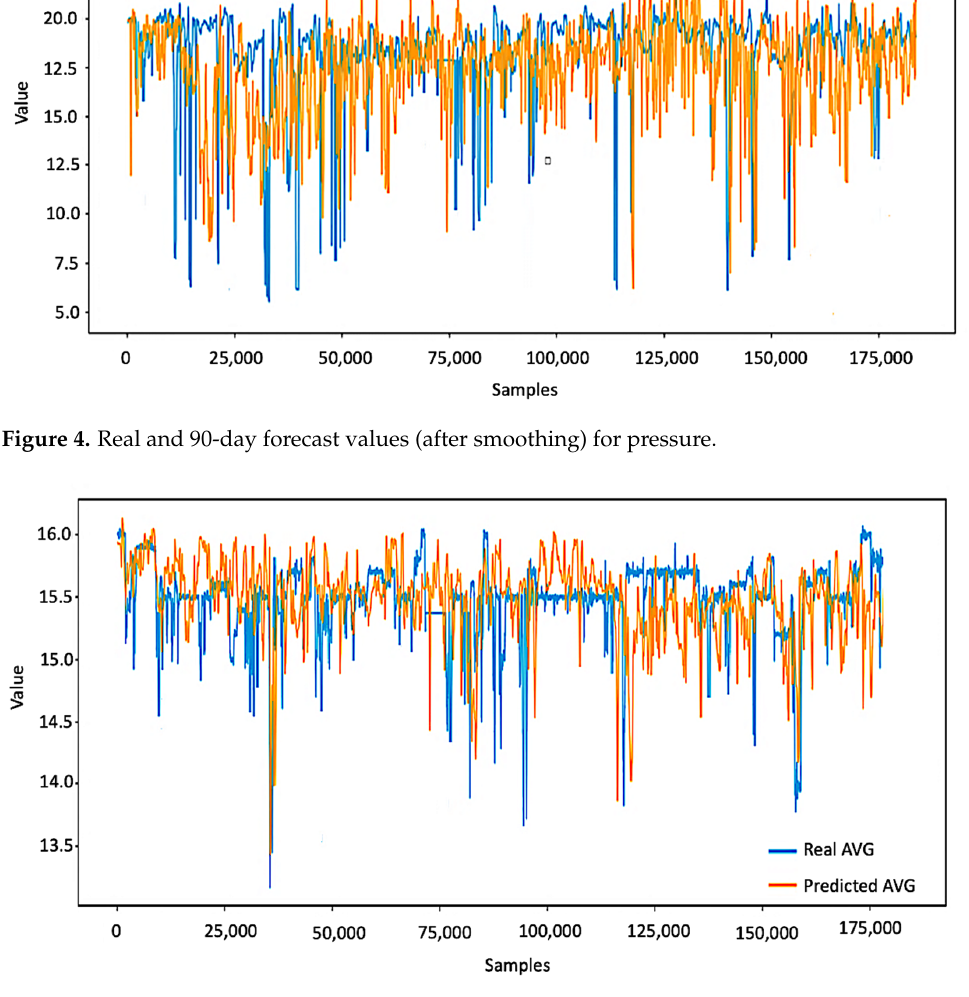
Figure 5. Real and 90-day forecast values (after smoothing) for torque.